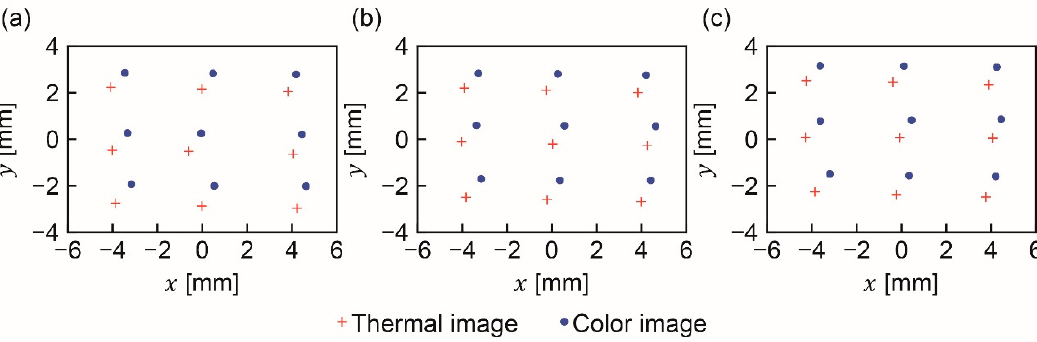
Figure 7. Example of a pair of captured images of a light source. ( a ) Thermal image and ( b ) color image (image pair No. 7 in Figure A1). The red and blue frames are identical to those shown in Figure 2.